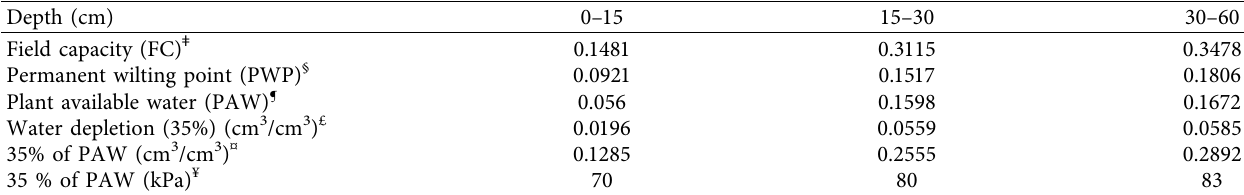
Table 2: Field capacity, permanent wilting point, plant available water, water depletion, and 35% depletion of plant available water in water content and soil matric potential units for each soil depth at TVREC in 2014. Parameters from 2014 were used during both growing